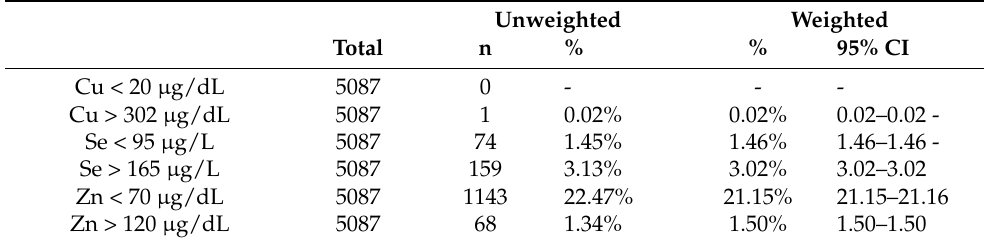
Table 3. Prevalence of excess and deficiency in copper, selenium, and zinc.